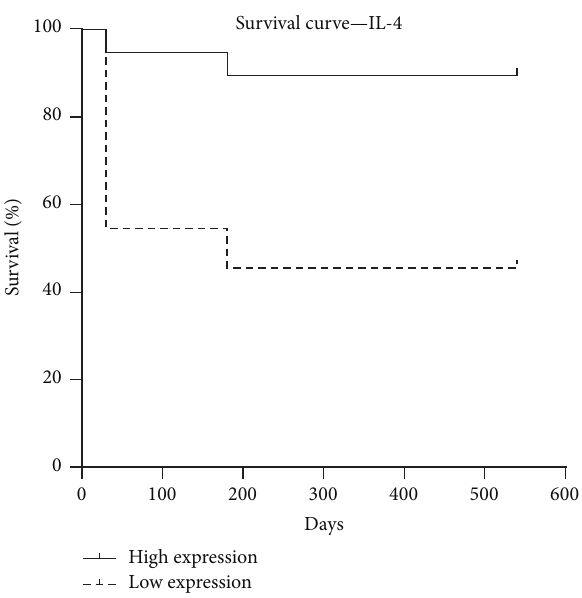
Figure 3: Survival curve of IL-4. Tumors of female dogs with high expression (black line) of IL-4 had lower chance of death compared with animals with low expression (dotted line). 𝑝 = 0.007 .